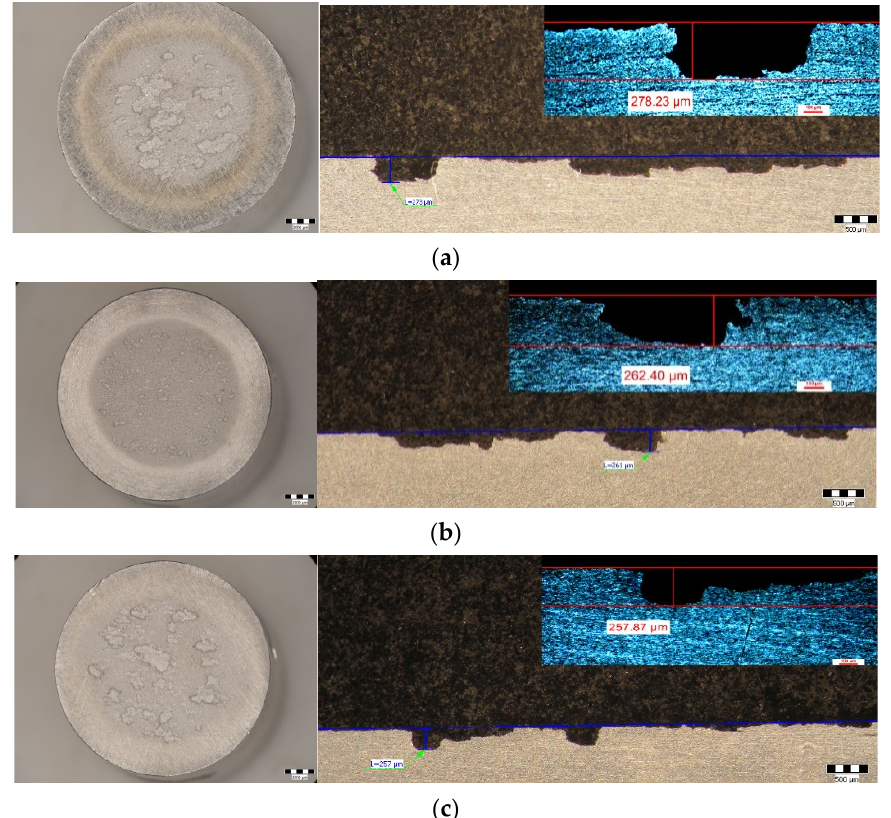
Figure 12. Appearance of macrostructural surfaces (left front section, parallel to the eroded surface, right in cross section, background image under an optical microscope, detail image under a stere- omicroscope) subjected to cavitation erosion from alloy 5083, poured followed by hardening solu- tion 450 ℃ /maintenance 100 min/cooling air quietly and subjected to artificial aging at 180 ℃ and different maintenance times: ( a ) 1 h; ( b ) 12 h; ( c ) 24 h .